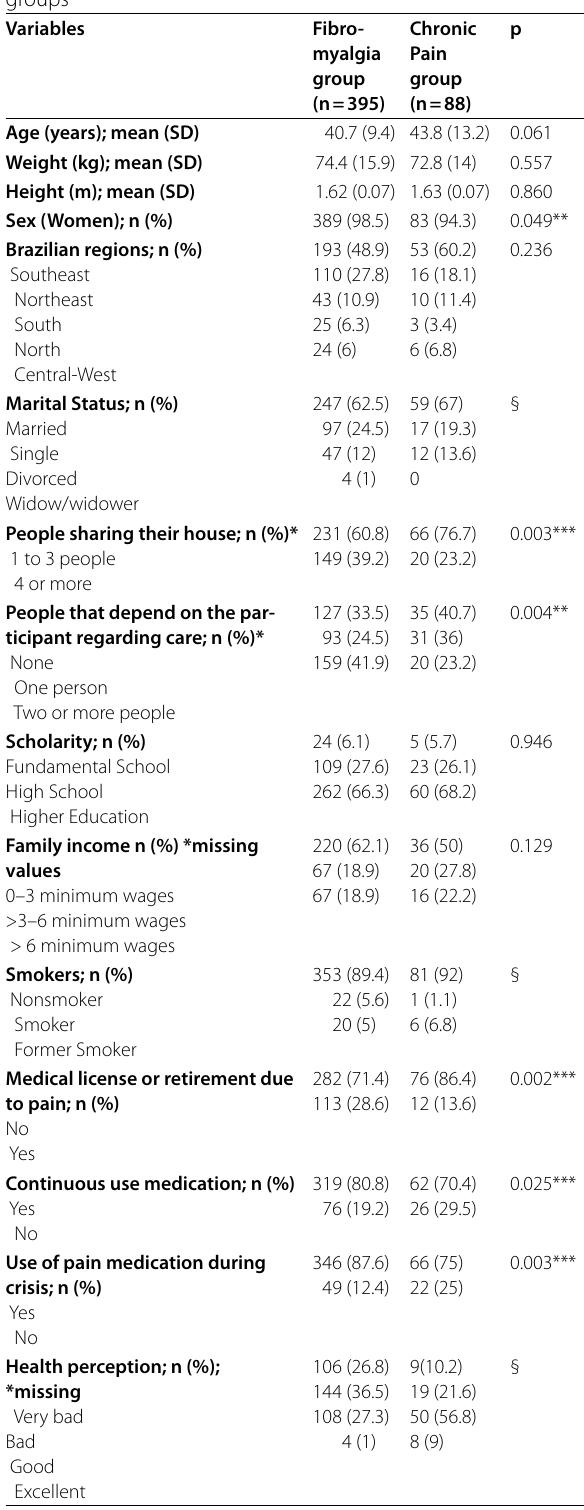
Table 1 Sociodemographic and clinical characteristics of both